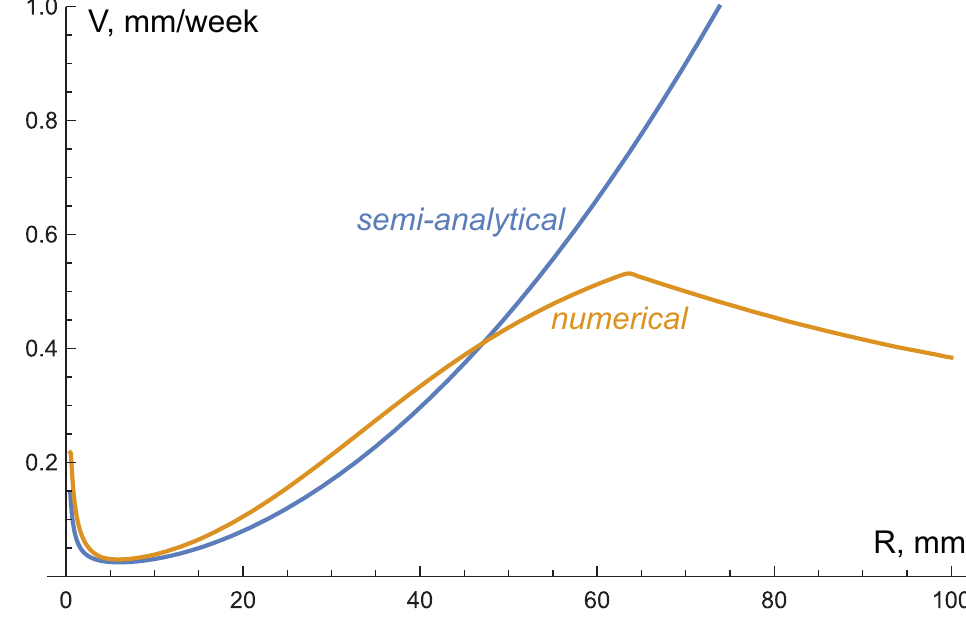
Figure 12. The speed of tumor growth V by its radius R produced by numerical simulations of the system of Equation (6) under K / µ = 0.003 and P = 64 (orange line) and semi-analytically estimated limit values of tumor growth speed, imposed by solid stress under K / µ = 0.003 (blue